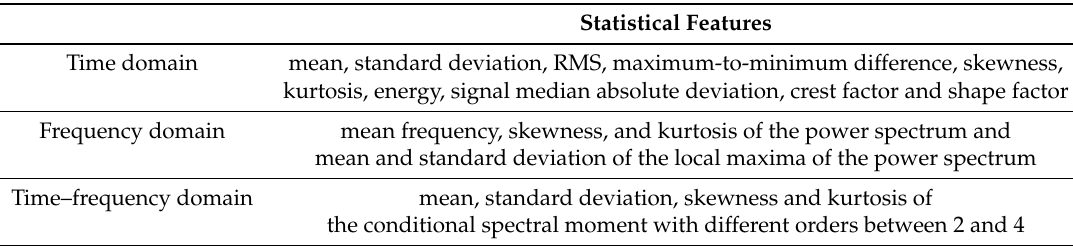
Table 1. Statistical features of time domain, frequency domain, and time–frequency